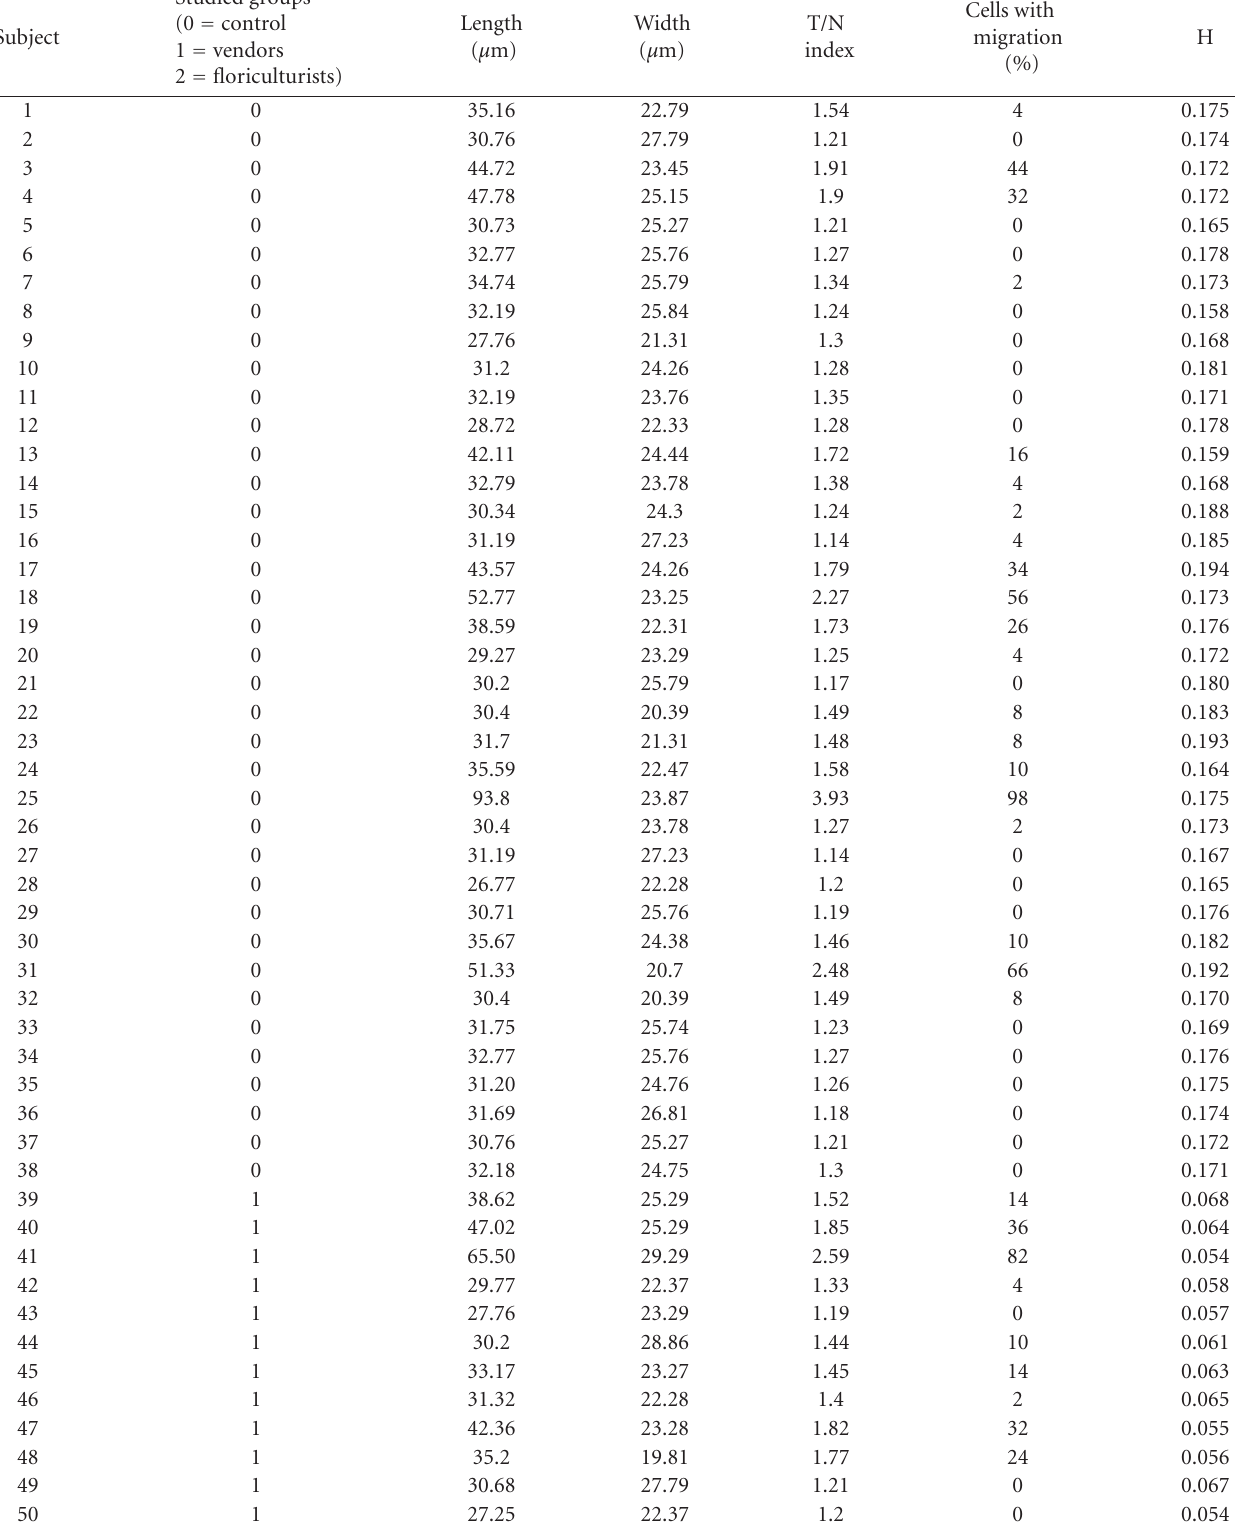
Table 2: Comet data, cells with DNA migration, and dispersion coe ffi cient values (H) of the study